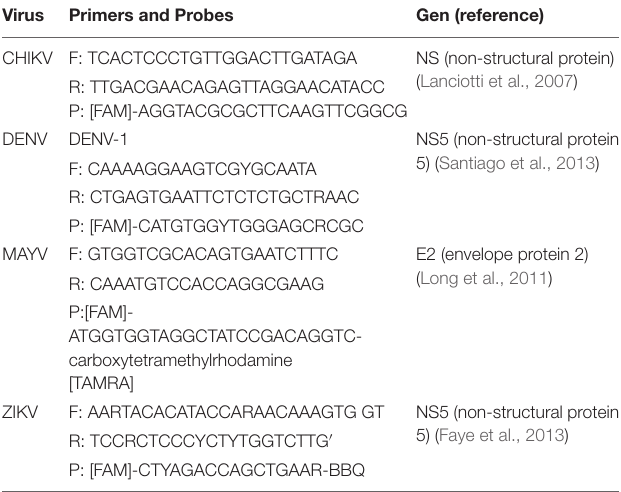
TABLE 1 | Primers and probes specific for each arbovirus. Virus Primers and Probes